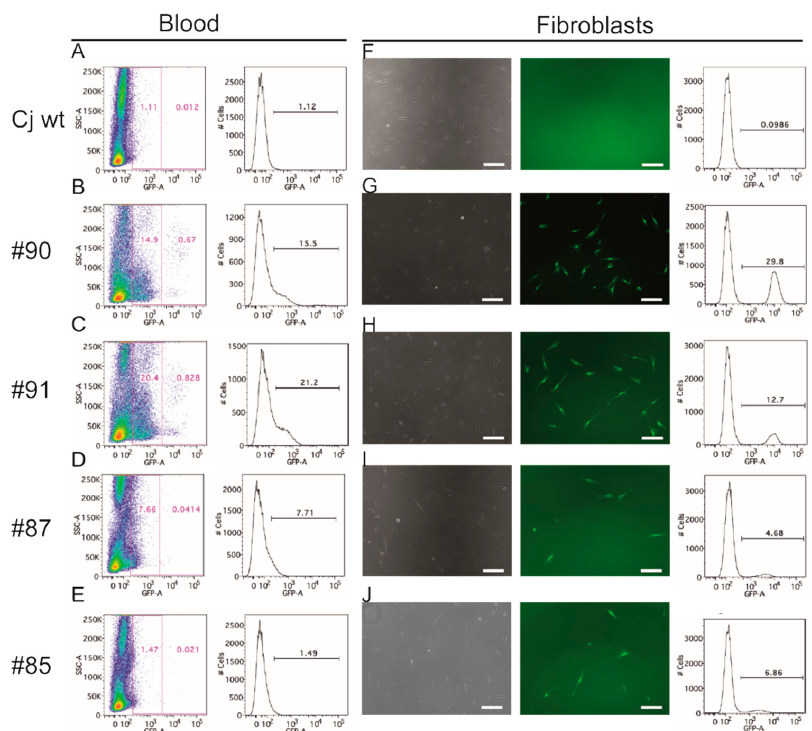
Figure 2. Quantification of EGFP-positive cells by flow cytometry. ( A – E ) Peripheral blood cells. ( A ) Wt control. ( B – E ) EGFP-transgenic animals #90, #91, #87, and #85, respectively. The transgenic animals show between 1.5% and 21.2% EGFP-positive cells. ( F – J ) Cultured skin fibroblasts. Left column: bright-field images; middle column: fluorescence images; right column: flow-cytometric quantification of EGFP-positive fibroblasts. Scale bars: 100 µ m. ( F ) Wt negative control. ( G – J ) EGFP-transgenic animals #90, #91, #87, and #85. The fibroblast cultures from the transgenic animals show between 4.7% and 29.8% EGFP-positive